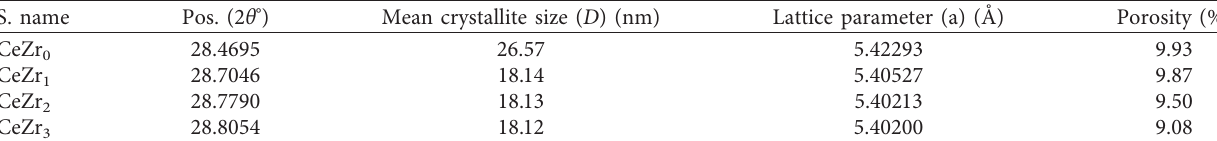
� 0.15 and (b) four all samples. 0.5 Sr 0.5 (Co 0.8 Fe 0.2 ) 1 − x Zr x O 3 − δ sample at concentration x � 0, 0.1, 0.15, and 0.2, 0 , CeZr 1 , CeZr 2 , and CeZr 3 for x